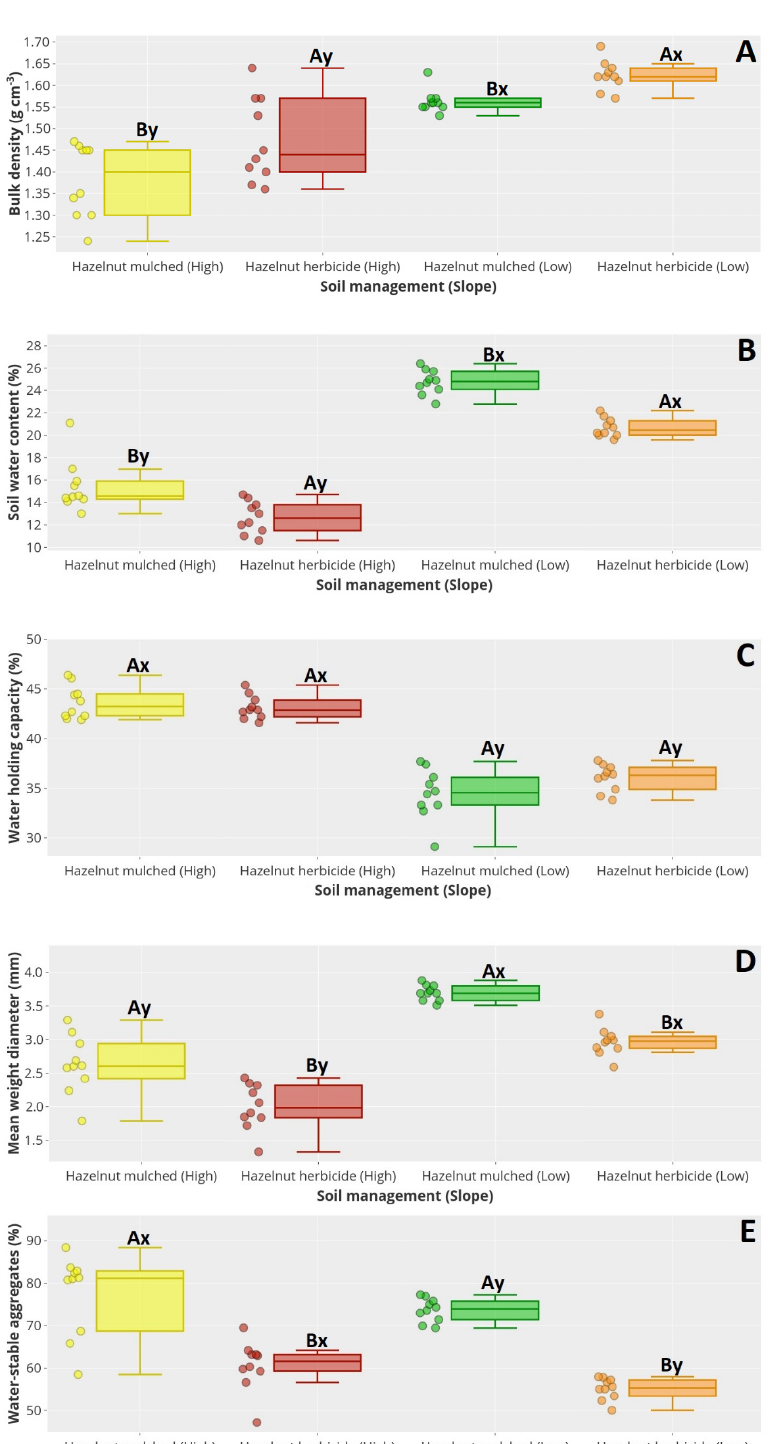
Figure 4. Soil organic matter (SOM) distribution according to the soil management and slopes. Upper hanging bar (high edge), lower hanging bar (low edge), upper box line (third quartile), line (median), and lower box line (first quartile). Different uppercase letters (A, B) represent significant differences between soil managements ( p < 0.05). Different lower- case letters (x, y) represent significant differences between slopes ( p < 0.05). 3.2. Hydrological Response and Soil Erosion Figures 5 and 6 summarize the impacts of soil management and slope on the soil hydrological response and erosion. Soil management was shown to impact all of the prop- erties besides RT. On the other hand, only the slope did not affect the SC and SOM loss. The significantly higher values of PT were noted in mulched treatments and lower slopes (Figure 5A). Figure 5B shows that RT was significantly higher in lower slopes. The ob- served IR (Figure 5C) was significantly higher in mulched treatments and lower slopes. The Run had the opposite reaction to the IR, where significantly higher values were noted in herbicide treatments and higher slopes (Figure 5D). Herbicide treatments resulted in a significantly higher SC compared to mulched (Figure 5E). The sediment losses were sig- nificantly higher in herbicide treatments and higher slopes (Figure 6A). Figure 6B shows that the significantly higher SOM losses were determined in herbicide treatments.